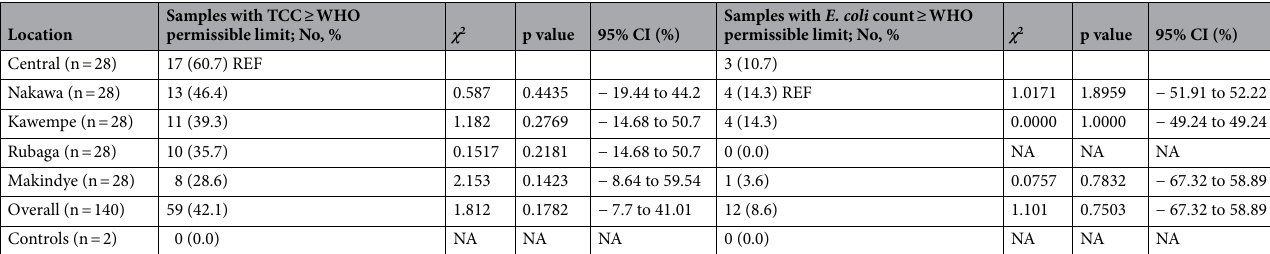
Table 4. Conformity of the commercial herbal medicines in Kampala to the permissible total coliform counts of bacteria recommended by the World Health Organization 18,19 . No number, TCC total coliform count, WHO World Health Organization, REF reference value, NA not applicable, χ 2 Chi-square, CI confidence interval.